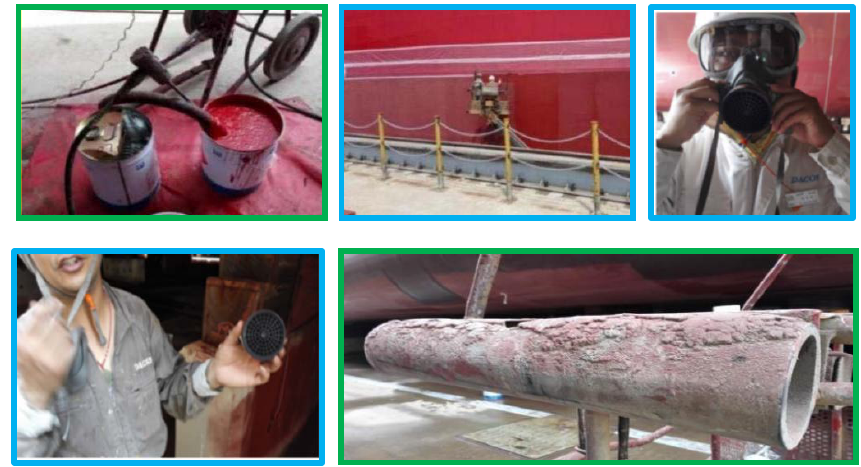
Figure 3. Current status of painting process in Chinese shipyards.